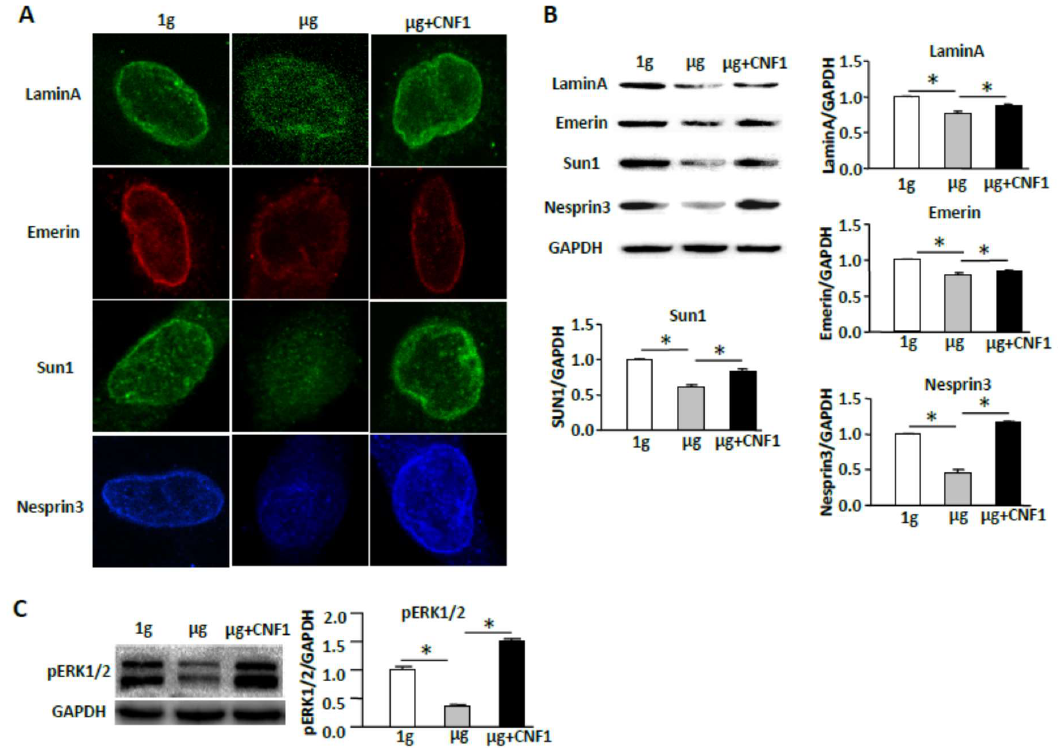
Figure 6. Simulated microgravity decreases nuclear positioning and down-regulates the ERK1/2 pathway. ( A ) BL6-10 cells cultured for two days at 1 g, µg, or µg + CNF1 in a Lab-Tek1 II Chamber Slide TM System were fixed with paraformaldehyde, and subsequently incubated with indicated antibodies and then incubated with FITC-labeled secondary antibodies, and observed by confocal microscopy (300× magnification). One representative experiment of three is shown; ( B , C ) Lysates prepared from BL6-10 cells cultured for two days at 1 g, µg, or µg + CNF1 were subjected to SDS-PAGE analysis. Proteins were transferred onto PVDF membranes and blotted with indicated antibodies. Western blot band signals were quantified by chemiluminescence. Densitometric values were normalized to matching GAPDH controls. Data represent the mean ± SD of three independent experiments. * p < 0.05 versus different groups.